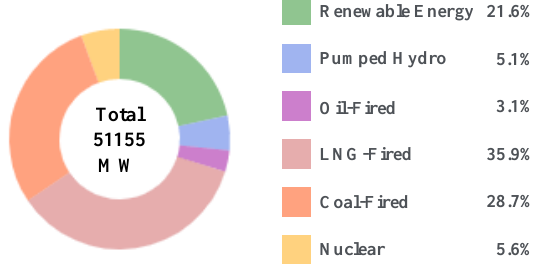
Figure 3. Energy mix in Taiwan in 2021.